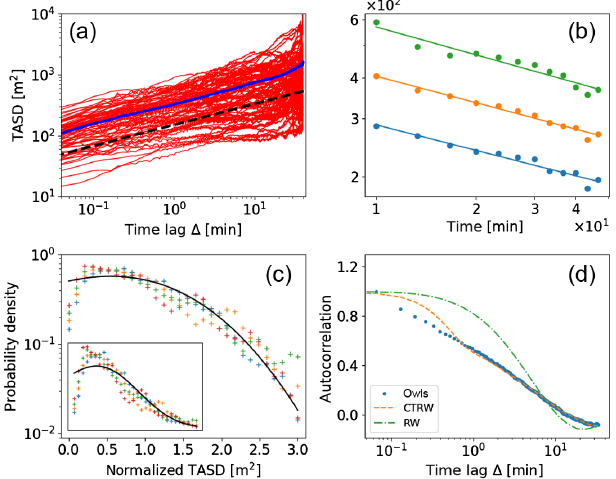
FIG. 4. (a) TASD (red solid lines) and averaged TASD (blue solid line) of 40-min ARSs of an owl, over time lag Δ . The dashed line scales as Δ 0 . 4 . (b) Averaged TASD over time t for Δ ¼ 10 s (blue), 40 s (orange), and 120 s (green), yielding powers of − 0 . 26 ; − 0 . 27 , and − 0 . 28 , respectively. (c) Probability density of the normalized TASD, ϕ ð ξ Þ [see Eq. (4)], during ARS for the same individual for Δ ¼ 100 , 200, 400, and 700 s. The dashed line is the Mittag-Leffler distribution [Eq. (4)] for α ¼ 0 . 6 . The inset shows the same plot on a linear scale. (d) Autocorre- lation function (blue dots) averaged over 100 ARS segments of 2000 s . The orange dashed and green dash-dotted lines are averages over 1000 simulations of subdiffusive CTRW (with α ¼ 0 . 6 ) and simple RW,